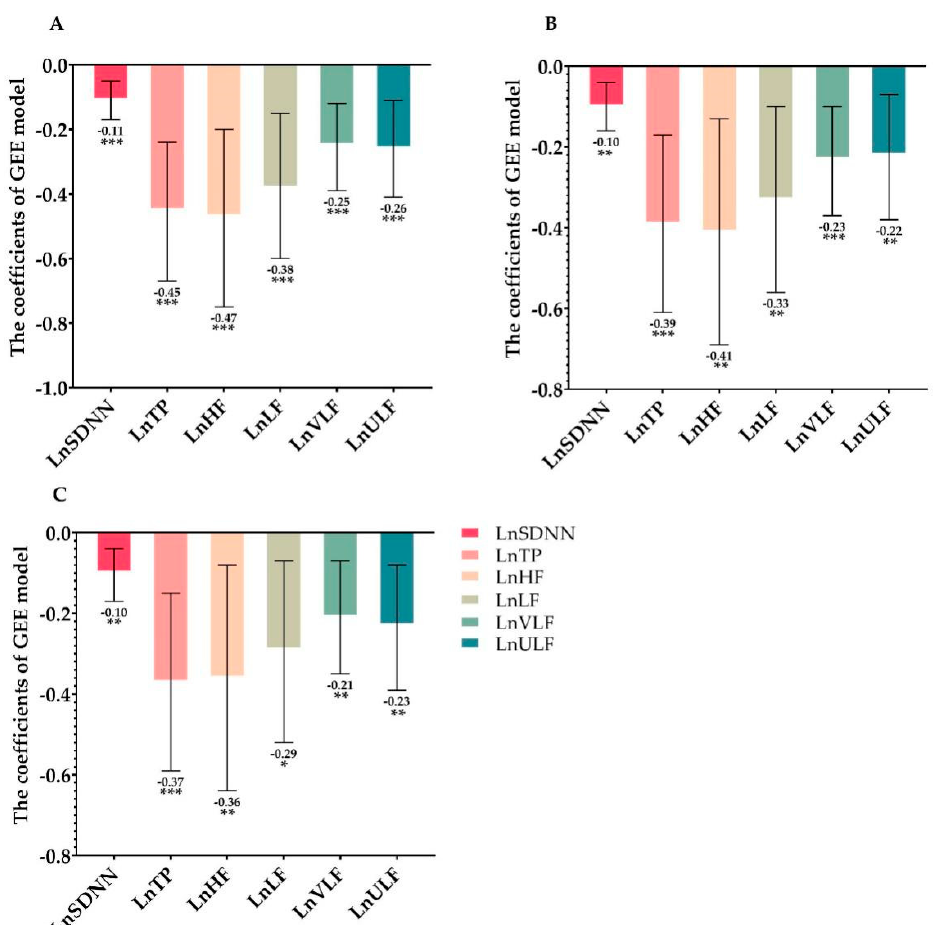
Figure 1. The coefficients (increase per SD) and 95% confidence interval of burnout scores at baseline with HRV parameters during one year using GEE models. ( A ) Model I: adjustment for age, sex, ACS type (UA, STEMI, NSTEMI), education level (junior middle school or below, high school/technical secondary school, college or higher), number of family members, monthly family income, medical history (hypertension, diabetes, hyperlipemia, stroke, family history of CVD, smoking at present, alcohol consumption), biochemical serum markers (glucose, total cholesterol, triglyceride, HDL-C, LDL-C). ( B ) Model II: Model I + additional adjustment for anxiety. ( C ) Model III: Model I + additional adjustment for depression. HRV: heart rate variability; Ln: natural logarithm; SDNN: standard deviation of NN intervals; TP: total power; HF: high frequency; LF: low frequency; VLF: very low frequency; ULF: ultra-low frequency; GEE: Generalized estimating equation. *. p < 0.05; **. p ≤ 0.005; ***. p ≤ 0.001.